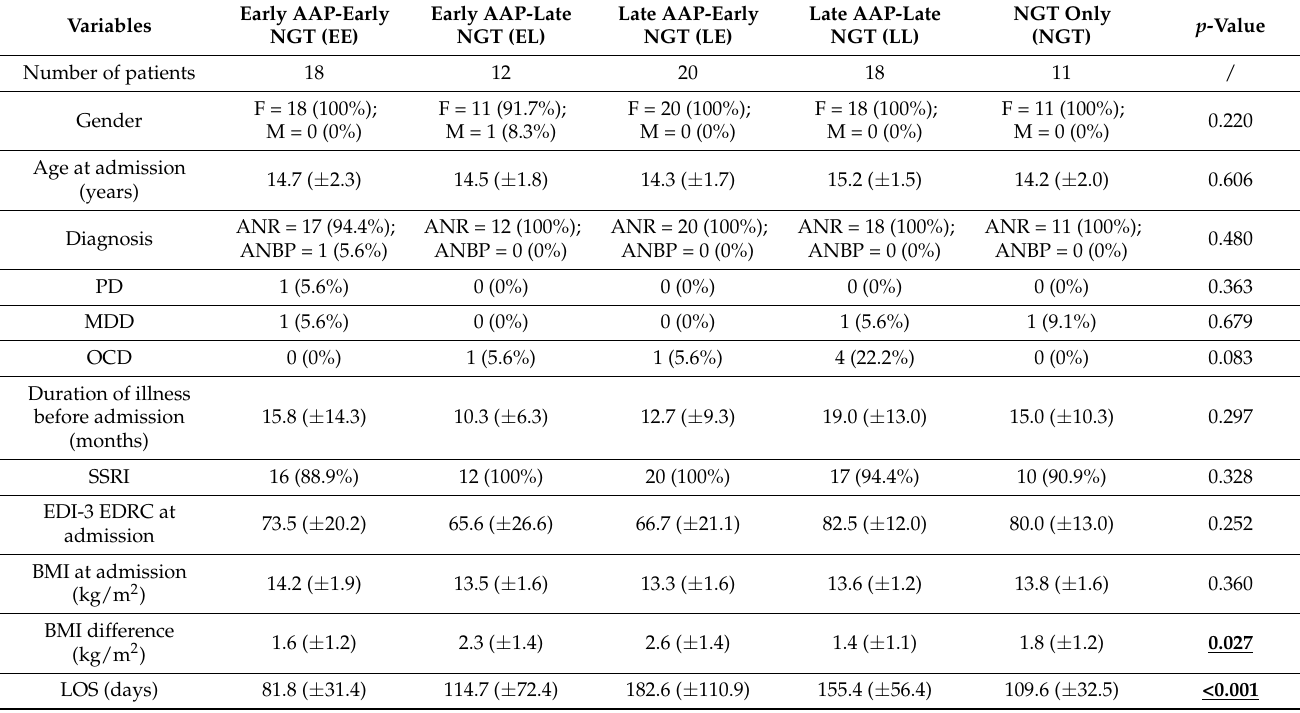
Table 1. Demographic characteristics of the sample. Continuous variables expressed as mean ( ±